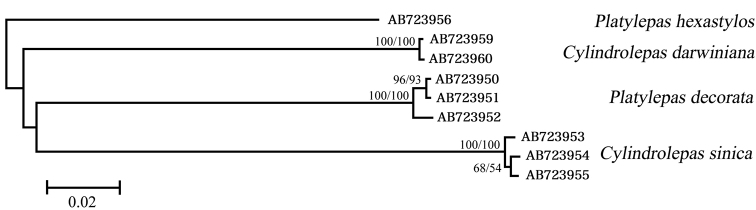
The consensus trees in the neighbour-joining and maximum-parsimony analyses were inferred from 1000 bootstrap replicates and both analyses were conducted using MEGA ver. 5.0 (Tamura et al. 2011). The sequences were aligned using MUSCLE included in MEGA ver. 5.0. At each node, the numbers separated by the slash indicate the percentage NJ and MP bootstrap support, respectively (1000 replicates).